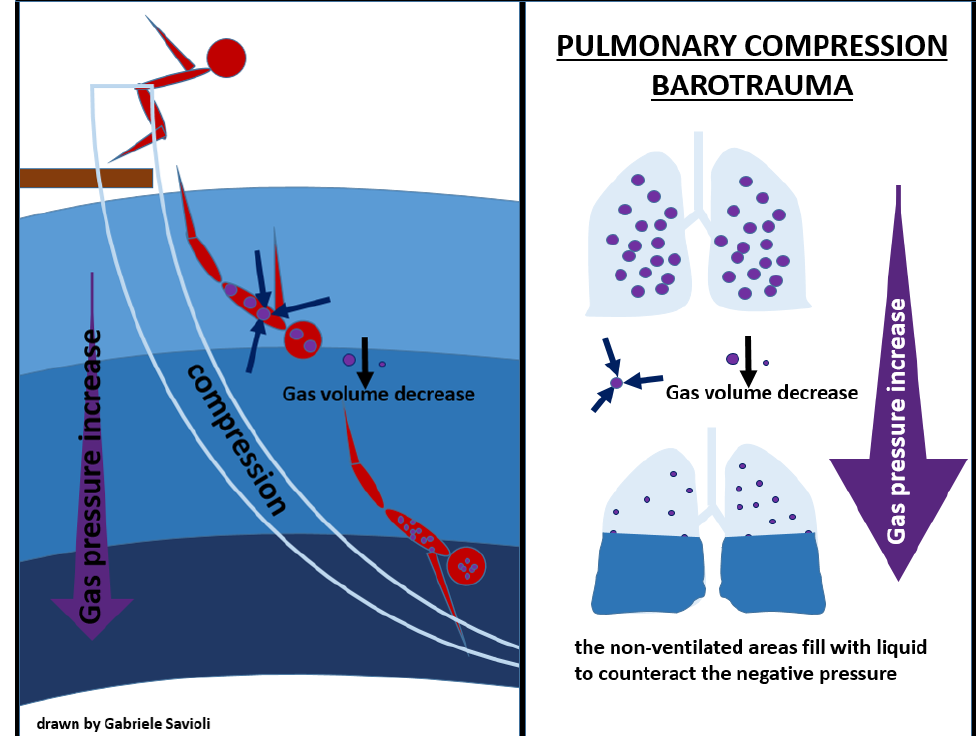
Figure 4. pulmonary compression barotrauma.